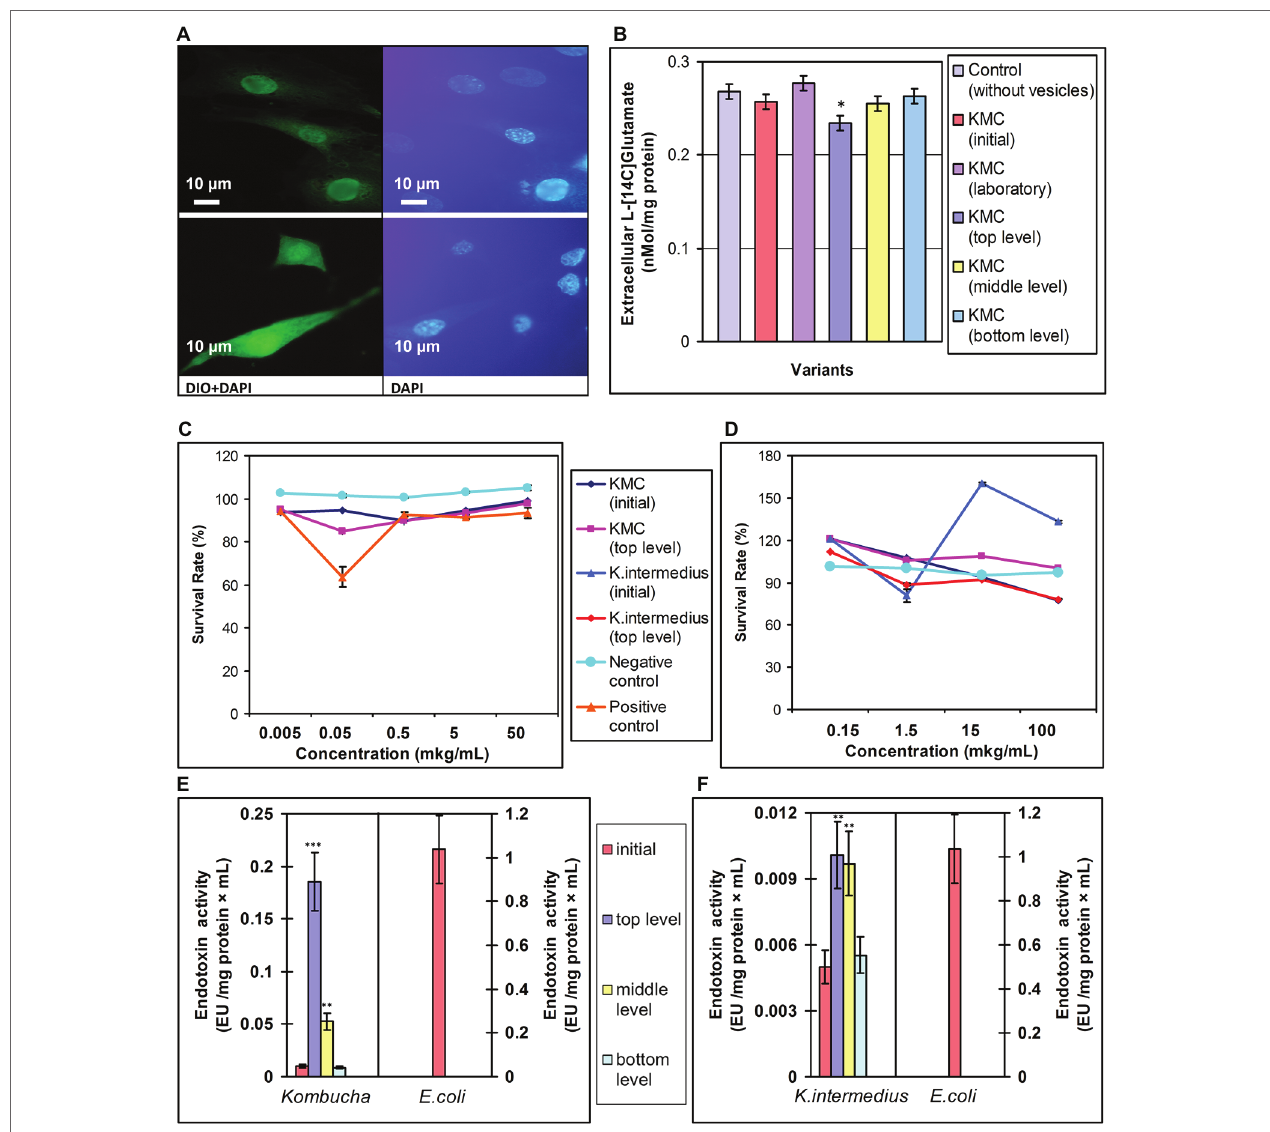
FIGURE 4 | A biosafety assessment of EVs after exposure of kombucha multimicrobial culture (KMC) under space/Mars-like stressors outboard the ISS and OMVs of K. intermedius , isolated from post-flight KMCs. (A) A micrograph of OMVs stained with the lipophilic dye DiO visible in murine fibroblasts. Fibroblast nuclei were stained with DAPI. (1, 2) – OMVs of K. intermedius from initial KMC; (3, 4) – OMVs of K. intermedius from top-located KMC (tKMC). Scale bar, 10 μ m. (B) The environment level of ʟ -[ 14 C] glutamate in the preparations of rat brain nerve terminals after co-cultivation with EVs from post-flight KMCs. (C) Survival rate of murine embryo fibroblasts after co-cultivation with different concentrations of OMVs from K. intermedius isolated from tKMC. (D) Survival rate of colorectal carcinoma cells COLO 205 after co-cultivation with different concentrations of OMVs/ K. intermedius , isolated from KMCs exposed outboard the ISS. (E) Endotoxin activity of EVs/ KMCs detected with the Limulus amebocyte lysate (LAL) assay compared to standard endotoxin activity from Escherichia coli . (F) Endotoxin activity of OMVs/ K. intermedius detected with the LAL assay. Data were shown as mean ± SD ( n = 3), * p ≤ 0.05; ** p ≤ 0.01; *** p ≤